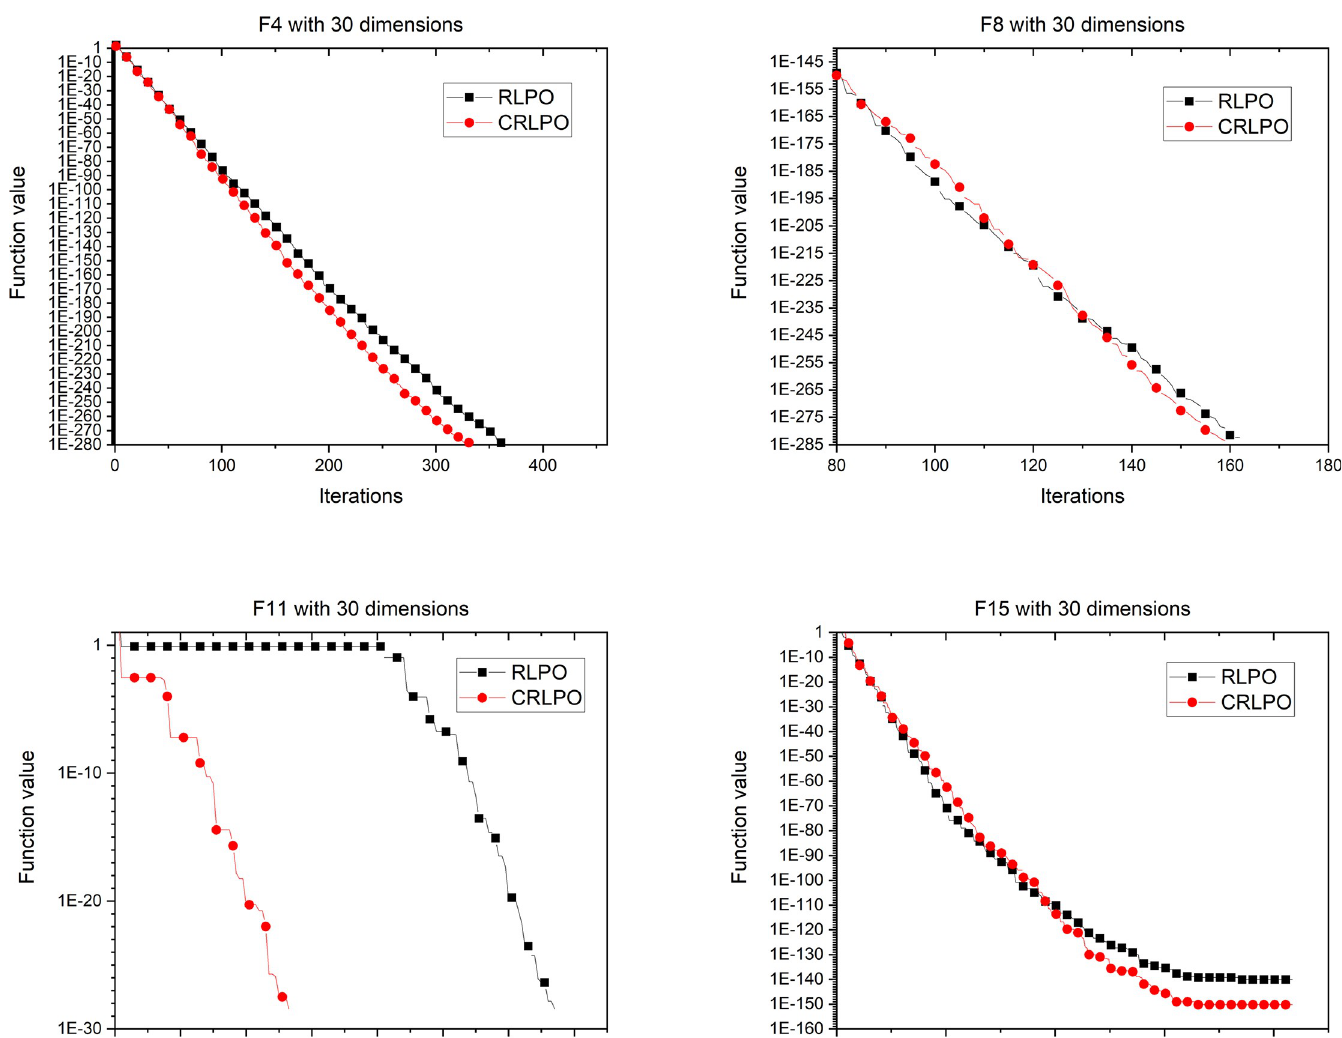
Fig 12. Convergence graph of CRLPO on 4 representative benchmark functions with 30